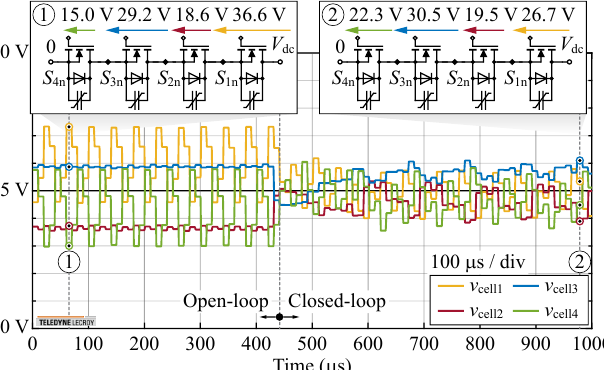
Figure 19. Cell voltages V cell , cf. (31), corresponding to the experiment from Figure 18 (transition from OL to CL balancing with nominal current). Data computed and filtered from oscilloscope waveforms. Note that the ideal cell voltages should be equal to 100 V/4 = 25